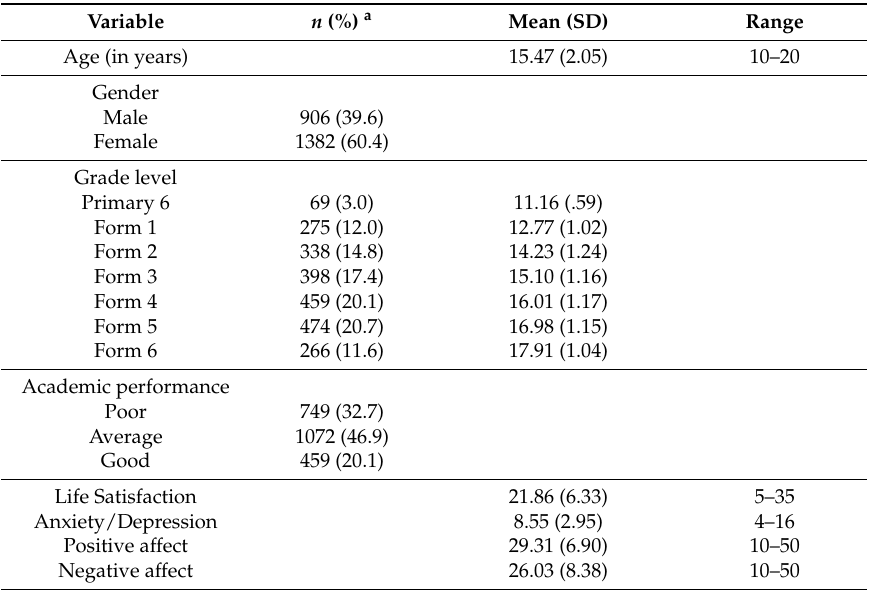
Table 1. Descriptive statistics for sample ( n =